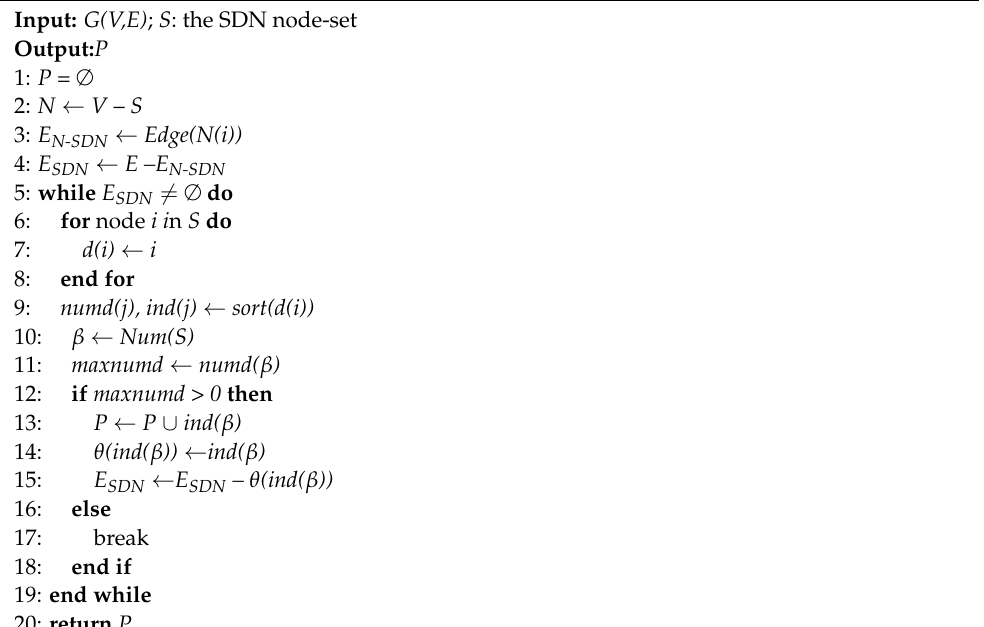
Algorithm 5 RMVCA (Restricted Minimum Vertex Cover